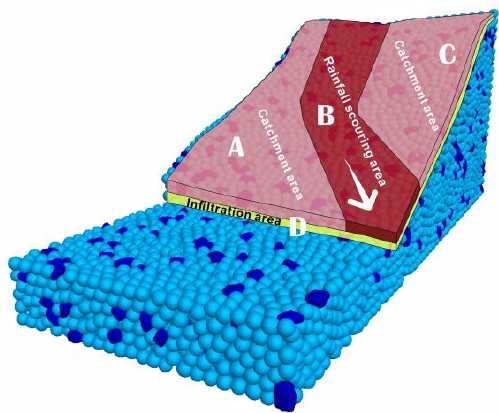
Figure 10. PFC3D fluid–solid coupling scouring